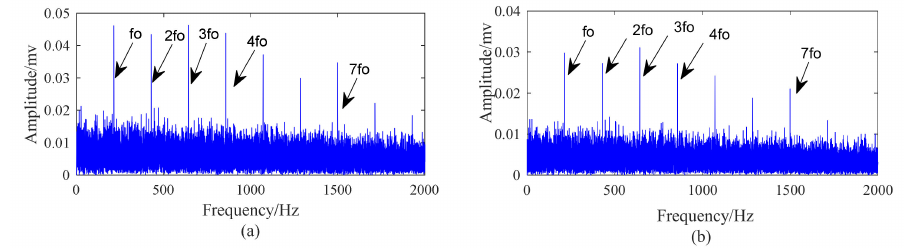
Figure 11. The diagnosis result obtained by IMF4 of the simulation signal of the bearings with the outer race fault: ( a ) the squared envelope spectrum of IMF4; ( b ) the teager energy spectrum of IMF4.